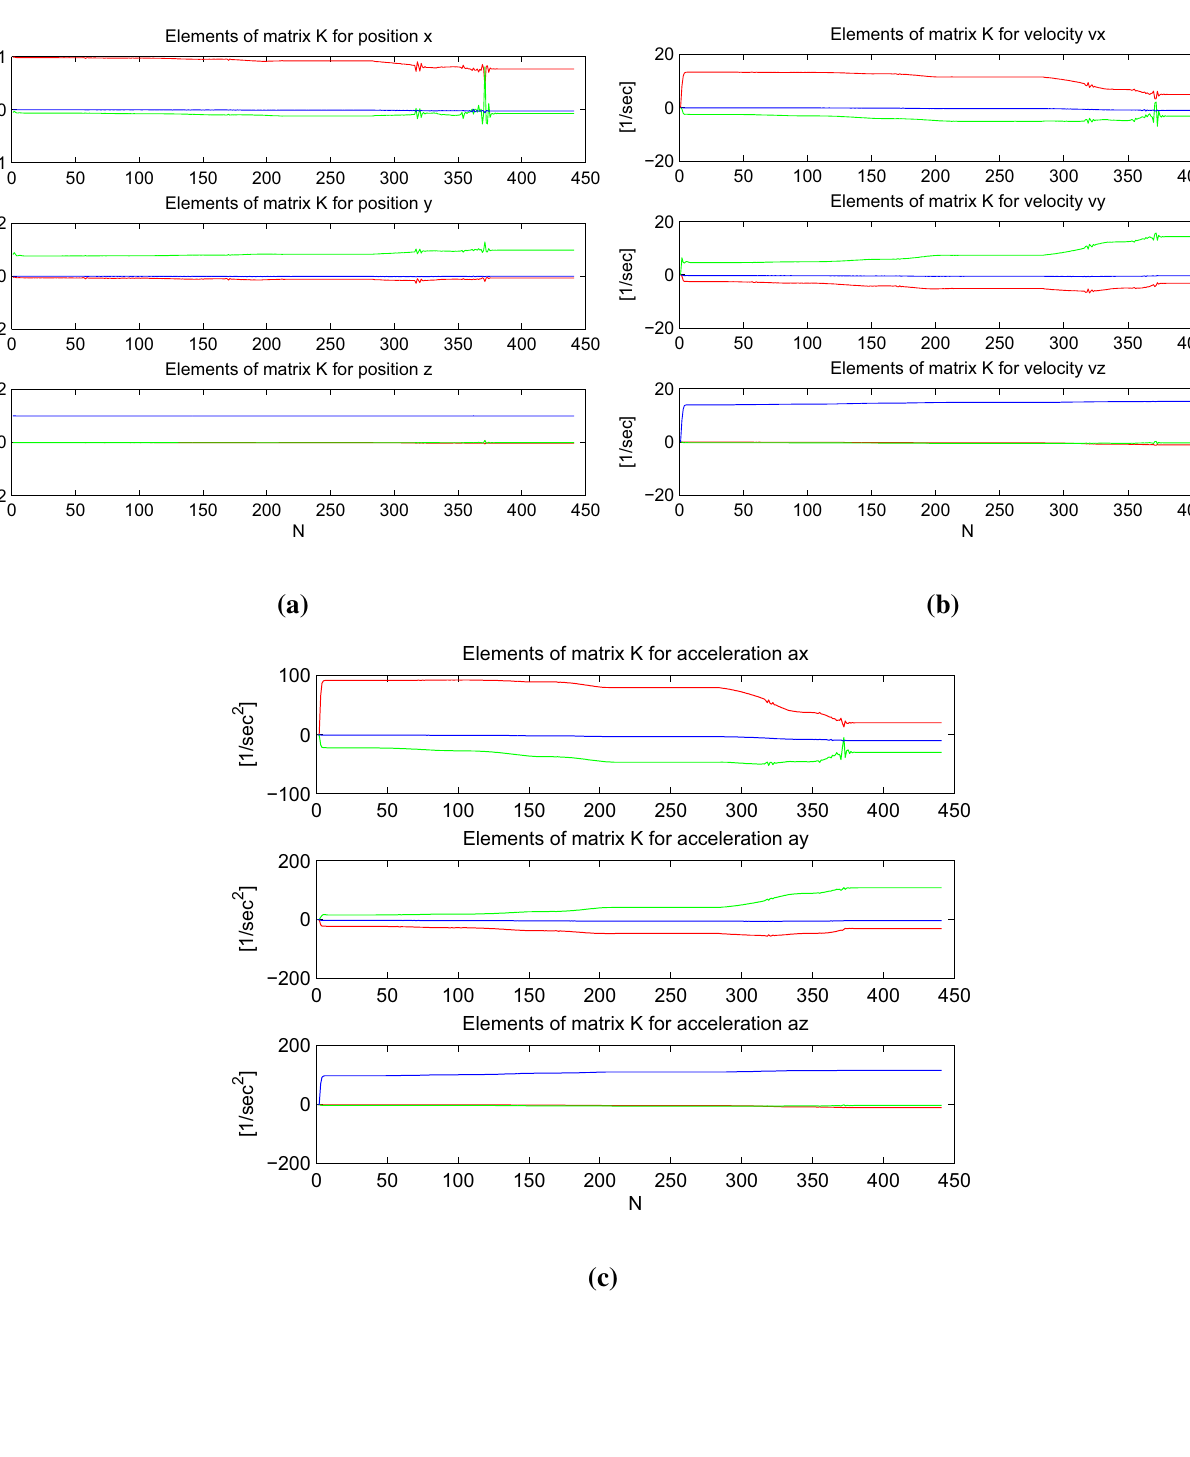
Figure 4. Elements of weighting matrix K . ( a ) Elements of weighting matrix K : position; ( b ) Elements of weighting matrix K : velocity. ( c ) Elements of weighting matrix K